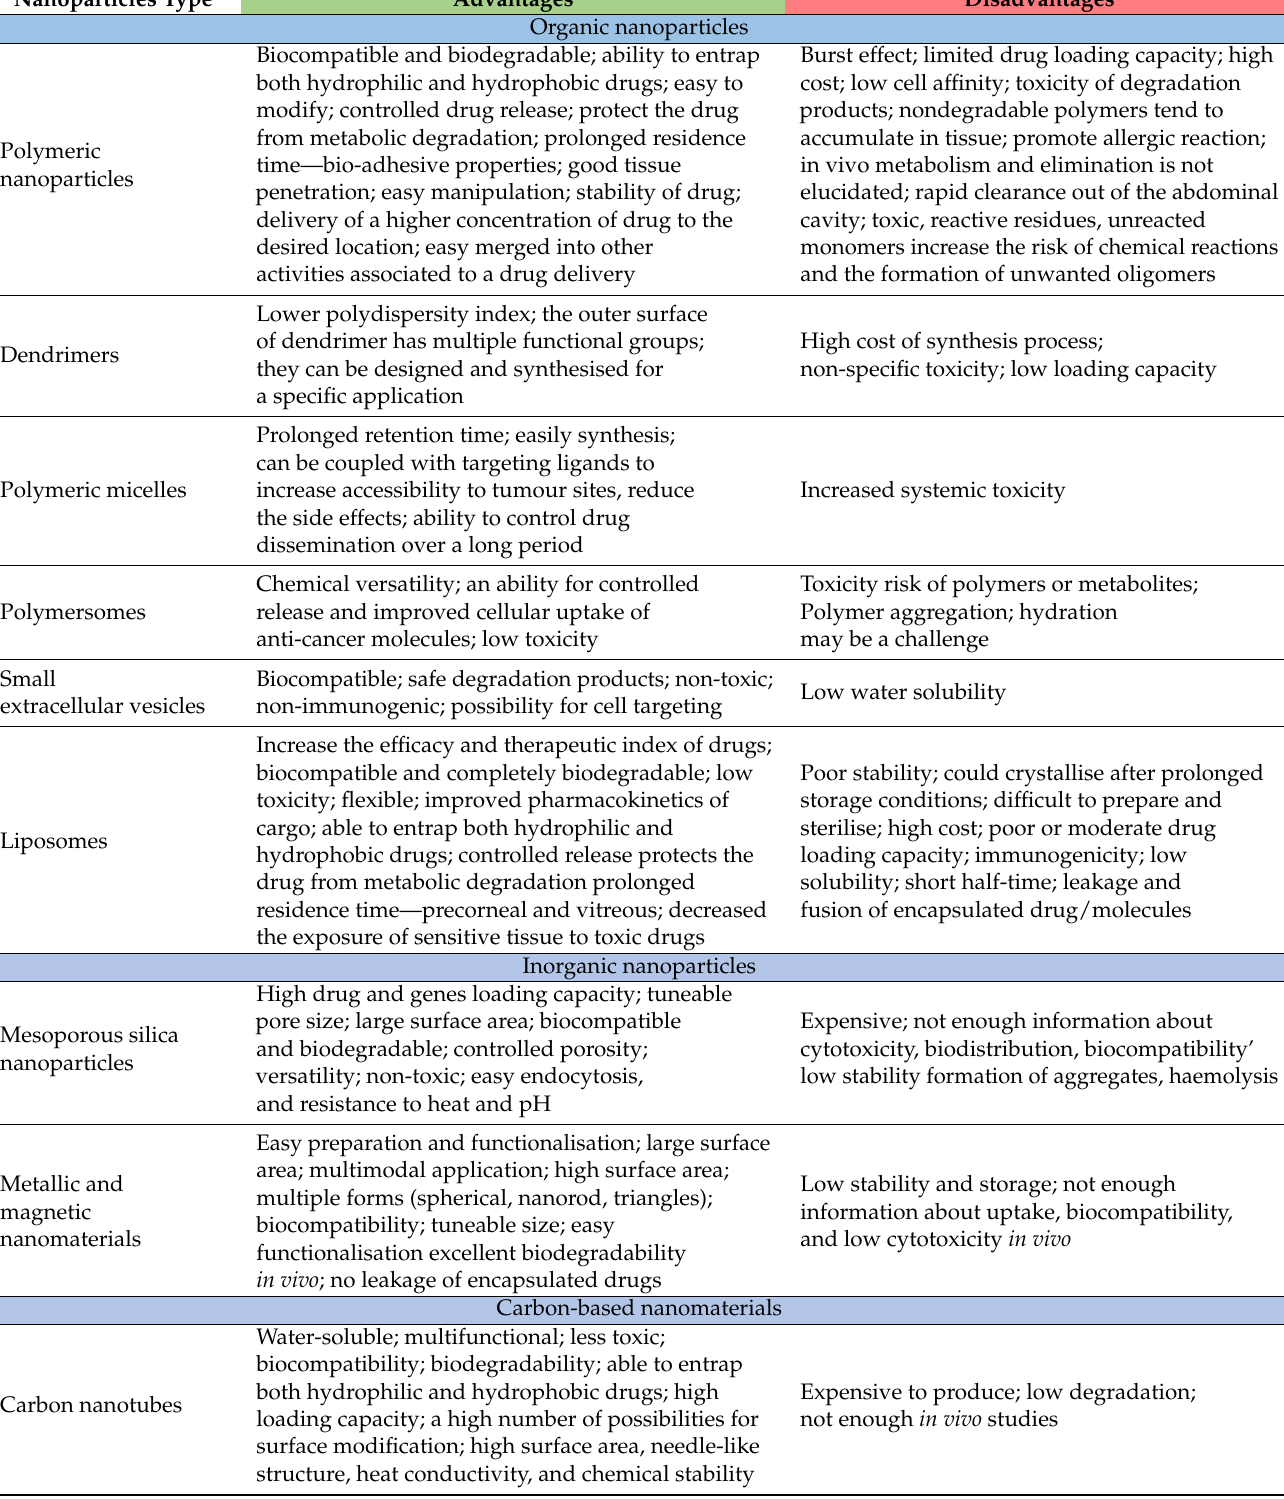
Table 2. Advantages and disadvantages of nanoparticles as cancer-drug delivery